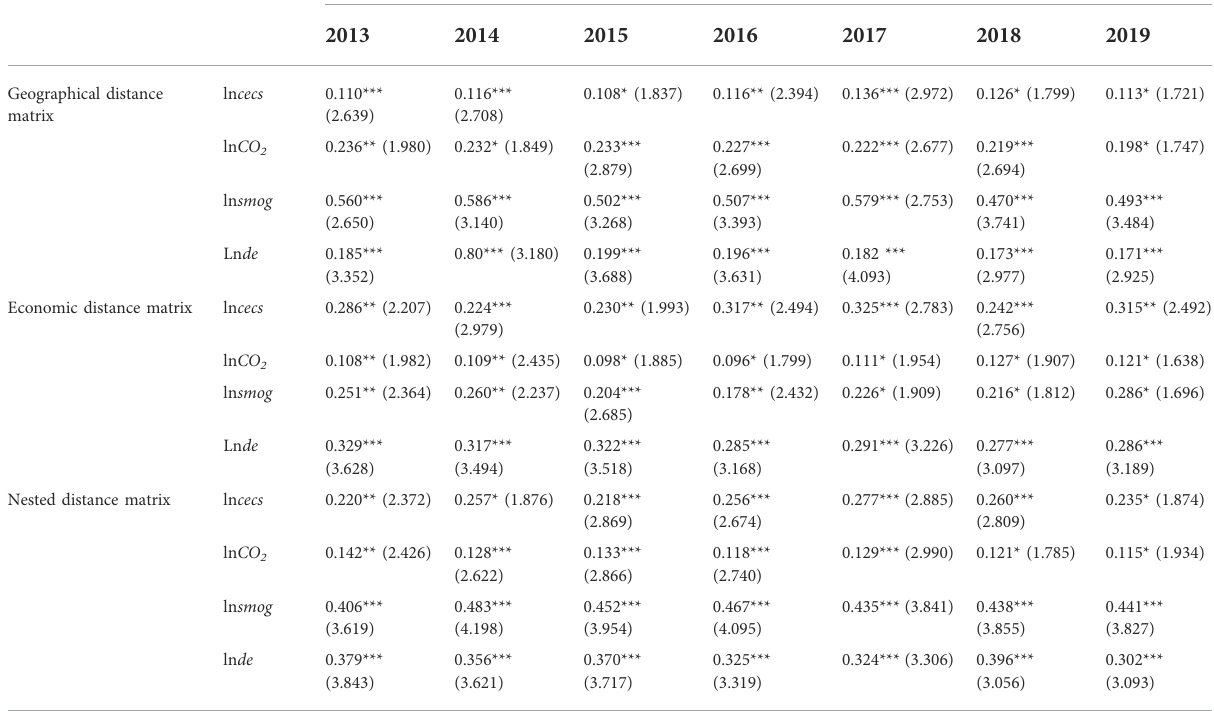
TABLE 3 Moran index coef fi cients for each of the main